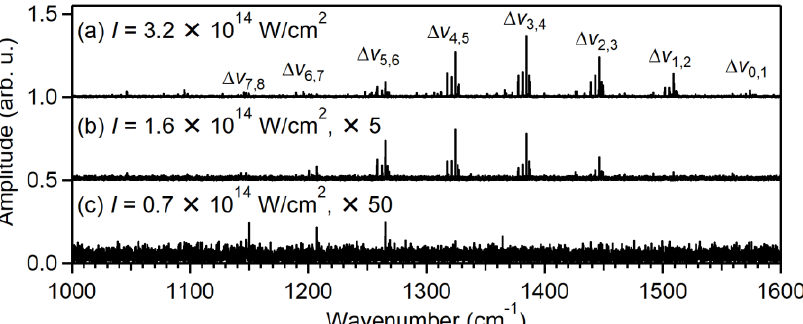
Fig. 2. Fourier transform of the difference between the ion yields of D 2+ and D + at the three different focal intensities, (a) 3.2 × 10 14 W/cm 2 , (b) 1.6 × 10 14 W/cm 2 , and (c) 0.7 × 10 14 W/cm 2 . The interval of the date point of the Fourier spectra is 0.0633 cm -1 and the uncertainty of the frequencies can be estimated to be the half of the interval, 0.032 cm -1 .